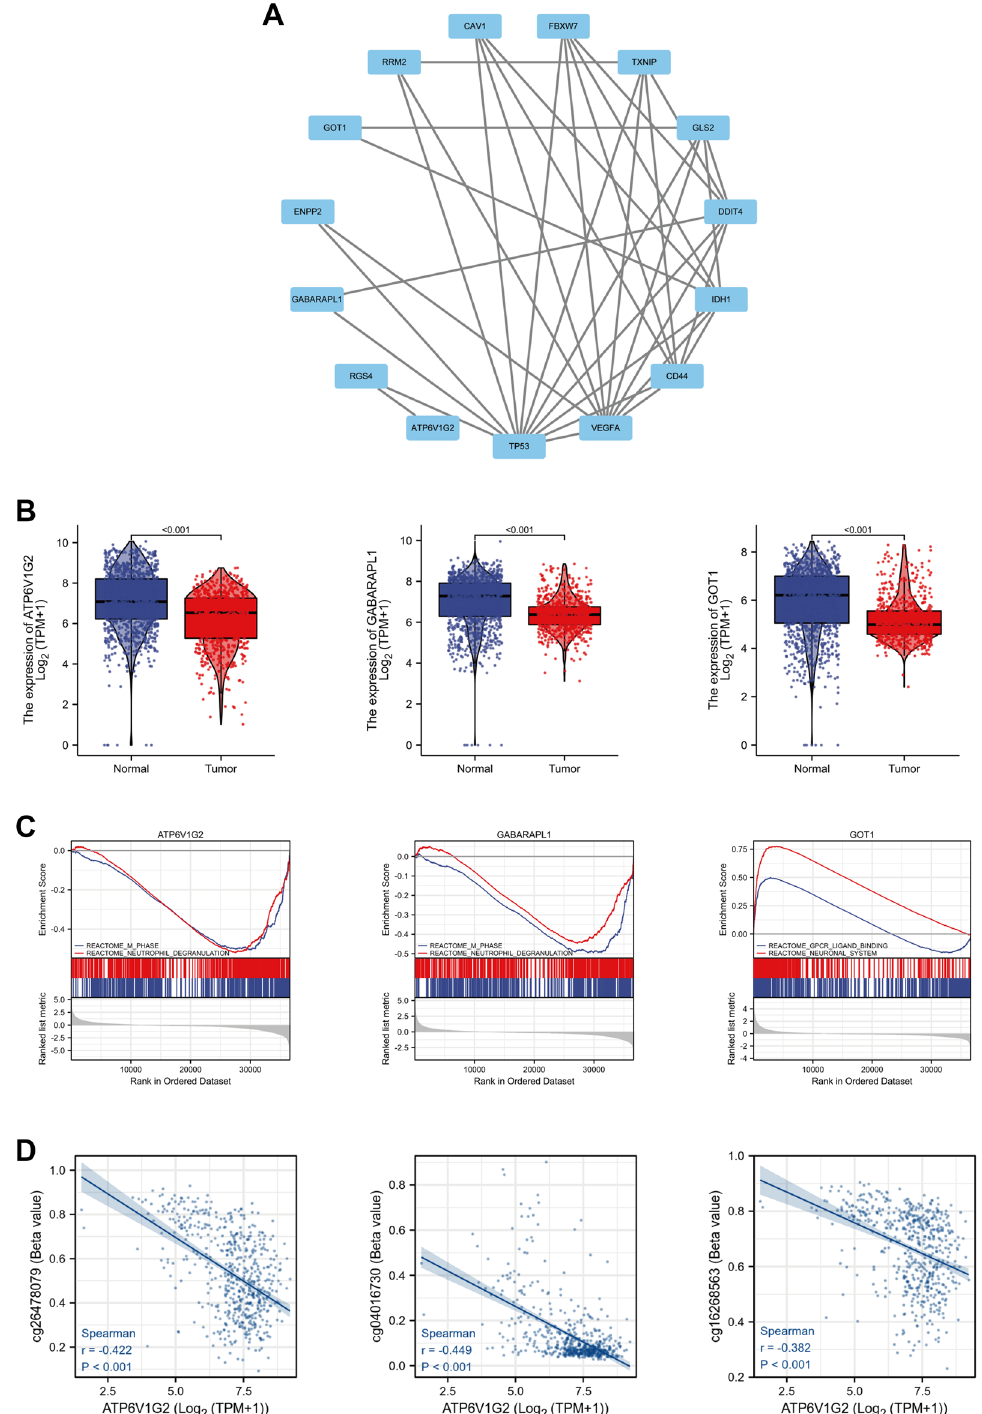
Figure 4. Hub genes identification and analyses. ( A ) The PPI network of ferroptosis-related genes. ( B ) Validation of hub genes expression in TCGA database and GTEx database. ( C ) GSEA of hub genes expression in TCGA database. ( D ) DNA methylation correlation analysis in TCGA